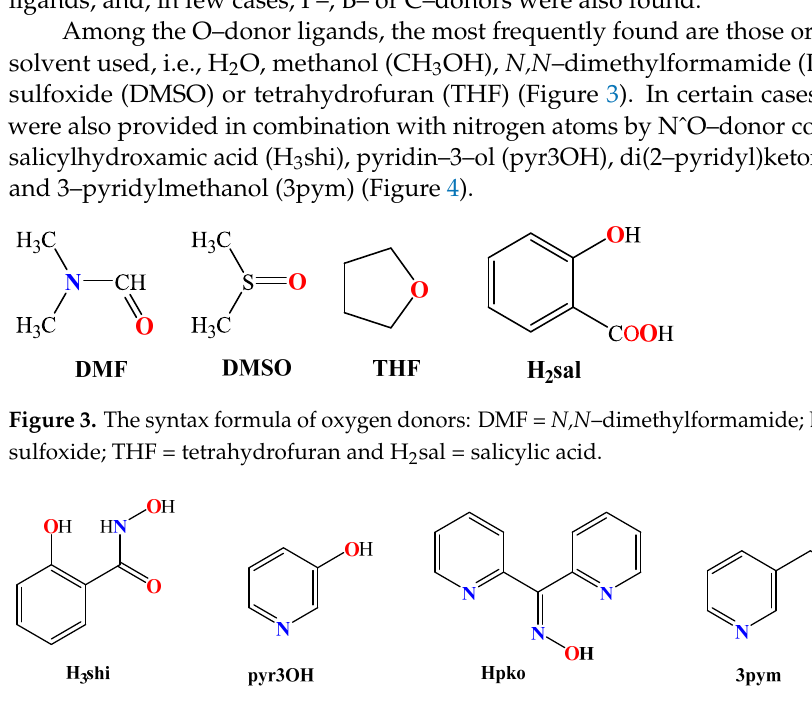
Figure 4. The syntax formula of the N^O–donors: H 3 shi = salicylhydroxamic acid; pyr3OH = pyridin–3–ol; Hpko = di(2–pyridyl)ketone oxime and 3pym = 3–pyridylmethanol.